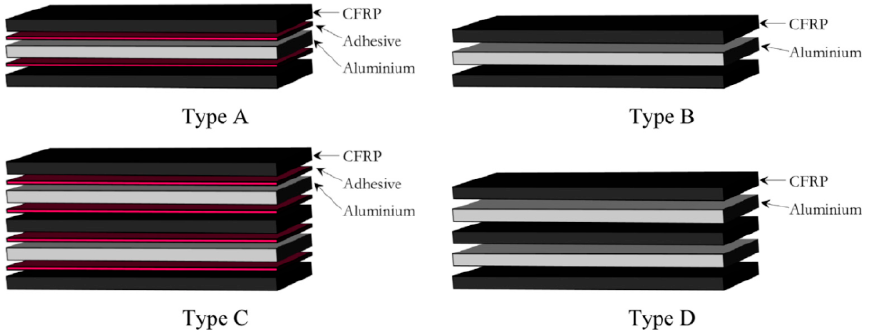
Figure 7. Stacking sequence of FMLs analysed by Bellini et al. [218] (reproduced with permission from [218]; copyright© 2021 Elsevier Ltd.).